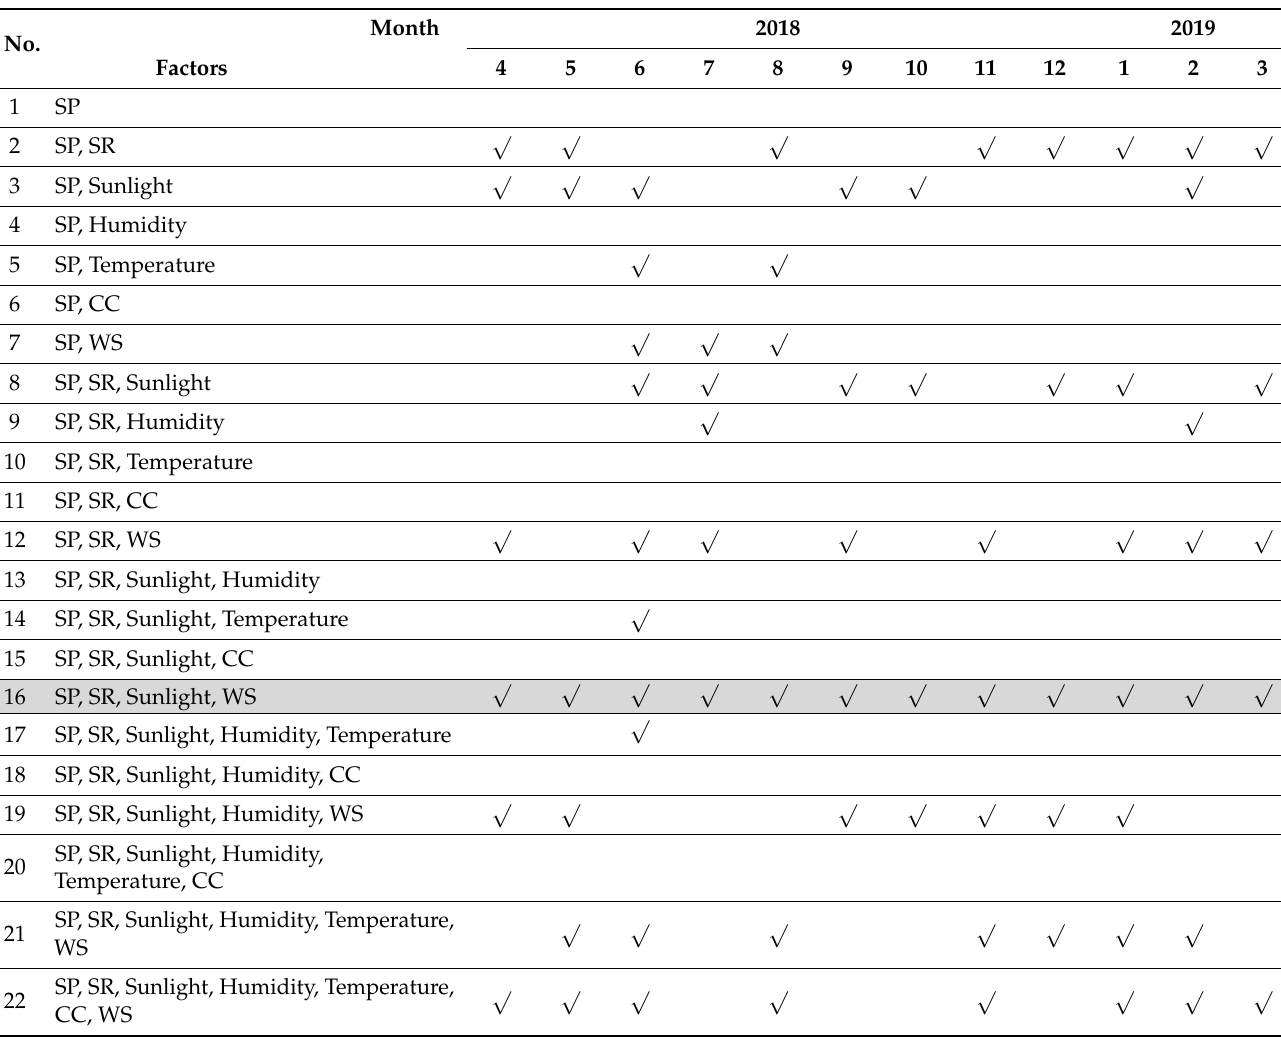
Figure 8. The meteorological factors affecting solar power forecasting by month. Table 5. Monthly performance comparison among the multivariate